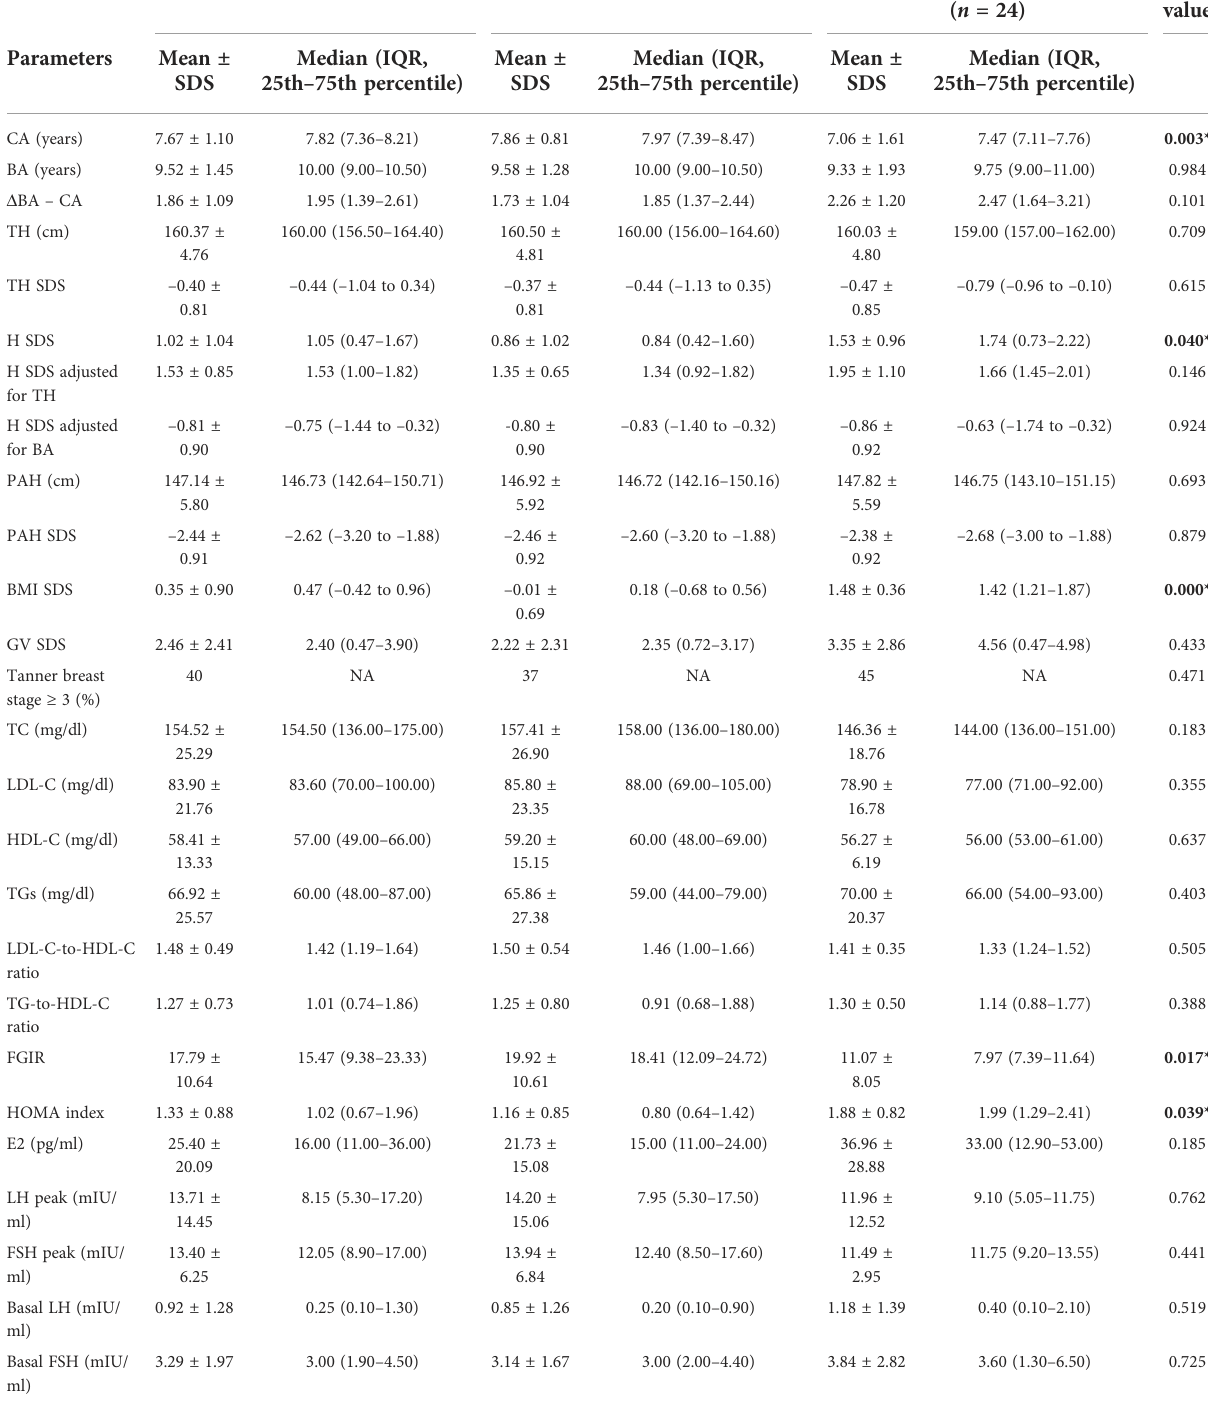
TABLE 1 Baseline features in the total population, group A and group B (T1). Total population ( n = 57) Group A: normal weight ( n = 33) Group B: overweight and obese